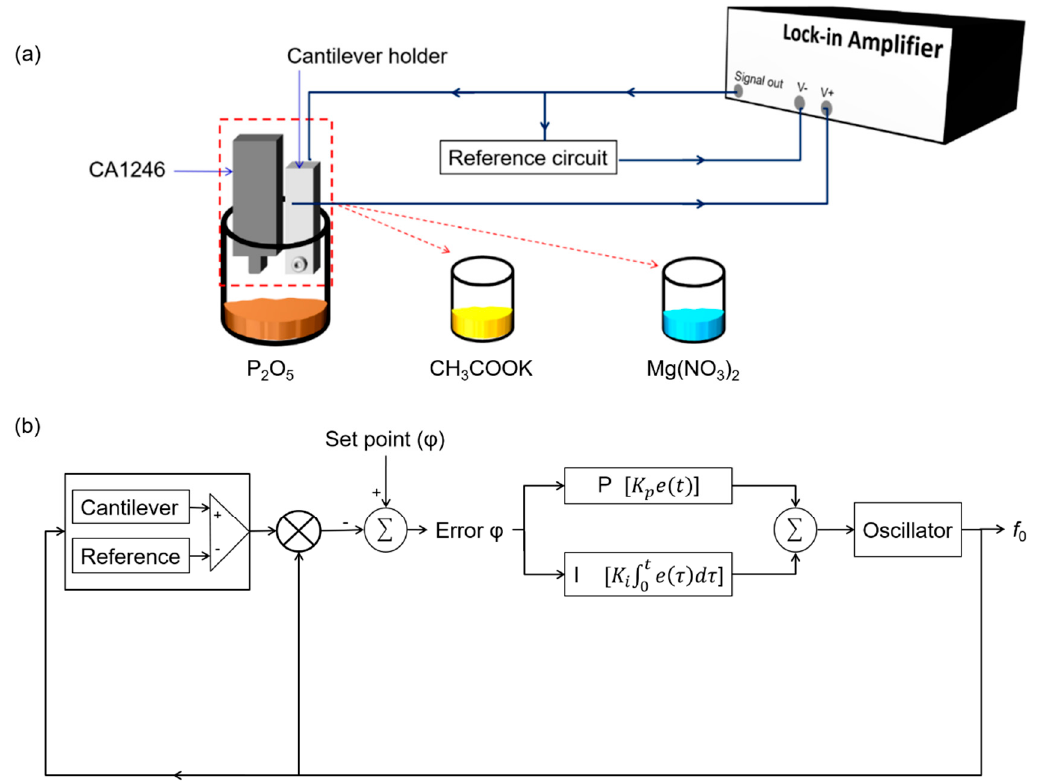
Figure 12. ( a ) Measurement setup for real-time measurement of rH using an electro-thermal piezoresistive cantilever with ZnO NRs and chitosan self-assembled monolayers and a commercial thermohygrometer. ( b ) A block diagram of the reference-subtraction control system.